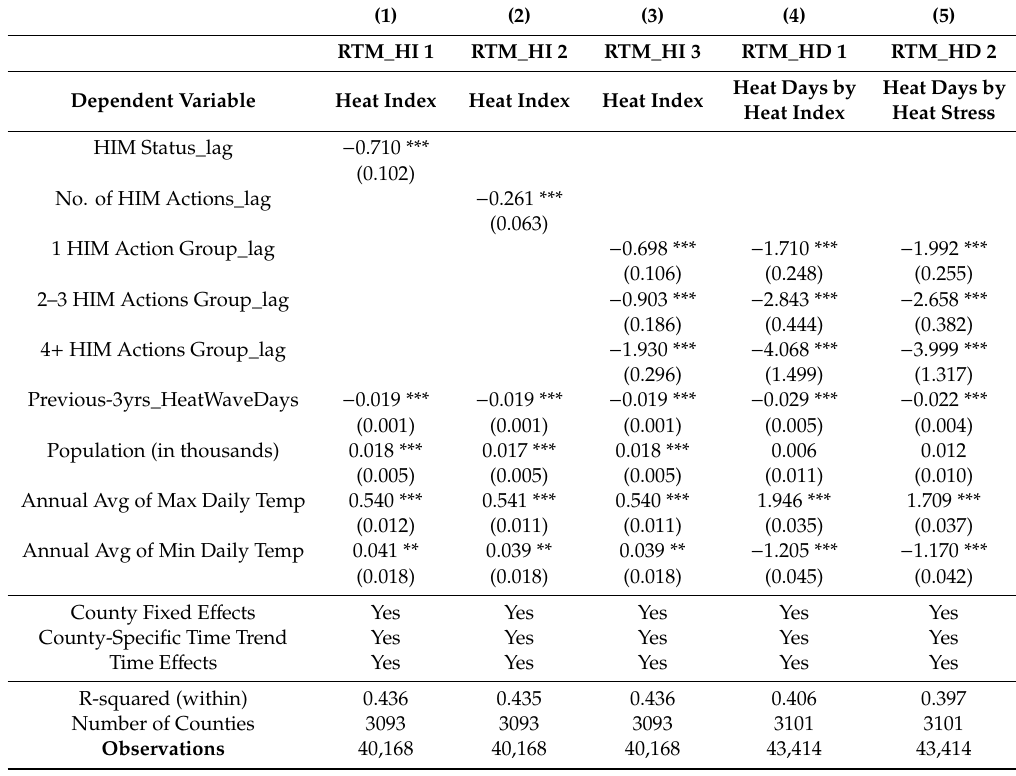
Table 6. Heat hazard model—the role of heat island mitigation actions random trend model